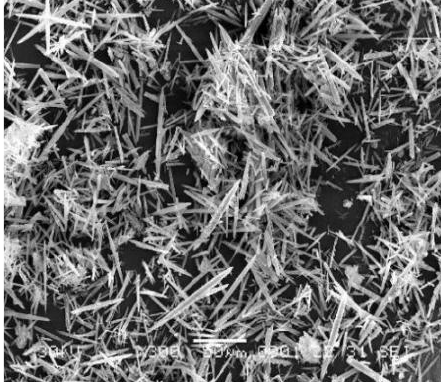
Figure 2. Calcium carbonate whisker.